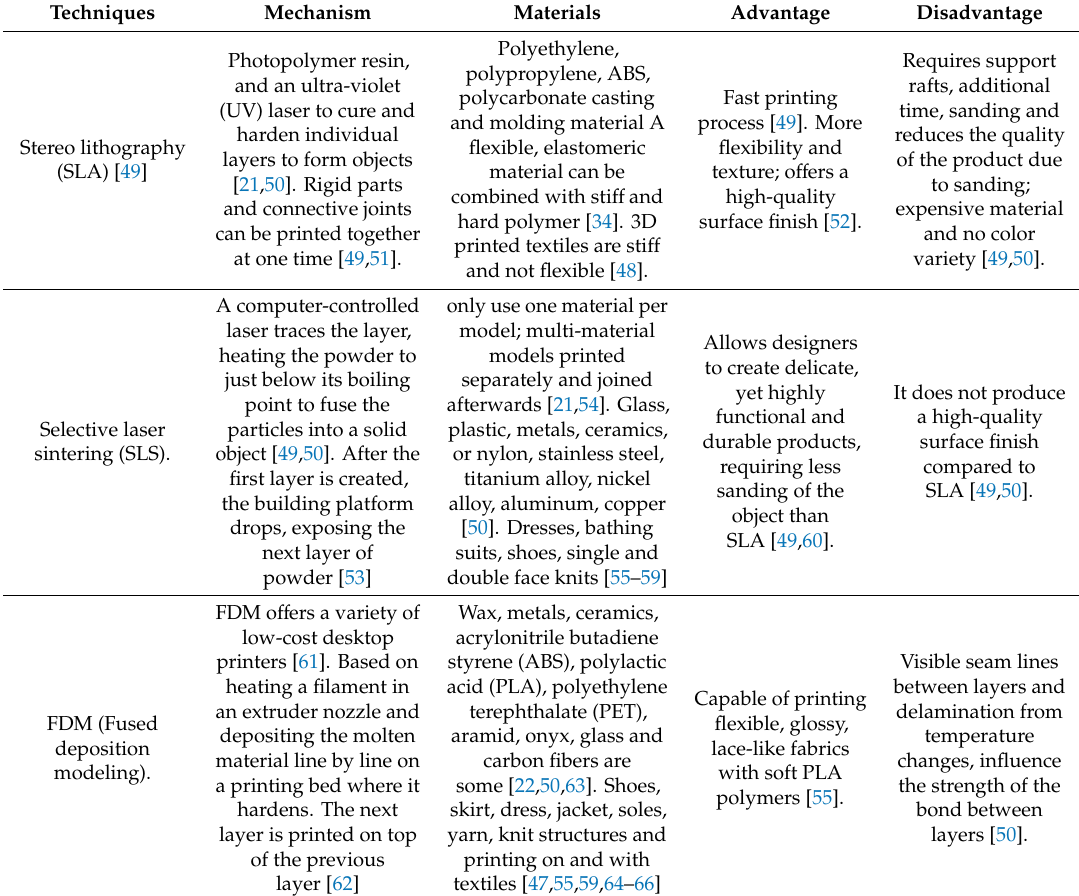
Table 1. A brief description of additive manufacturing techniques for 3D printing techniques for printing in the textile